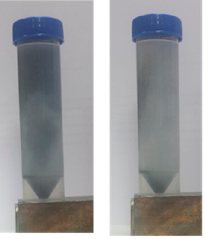
Figure 18. Magnetic separation of nanocomposites.